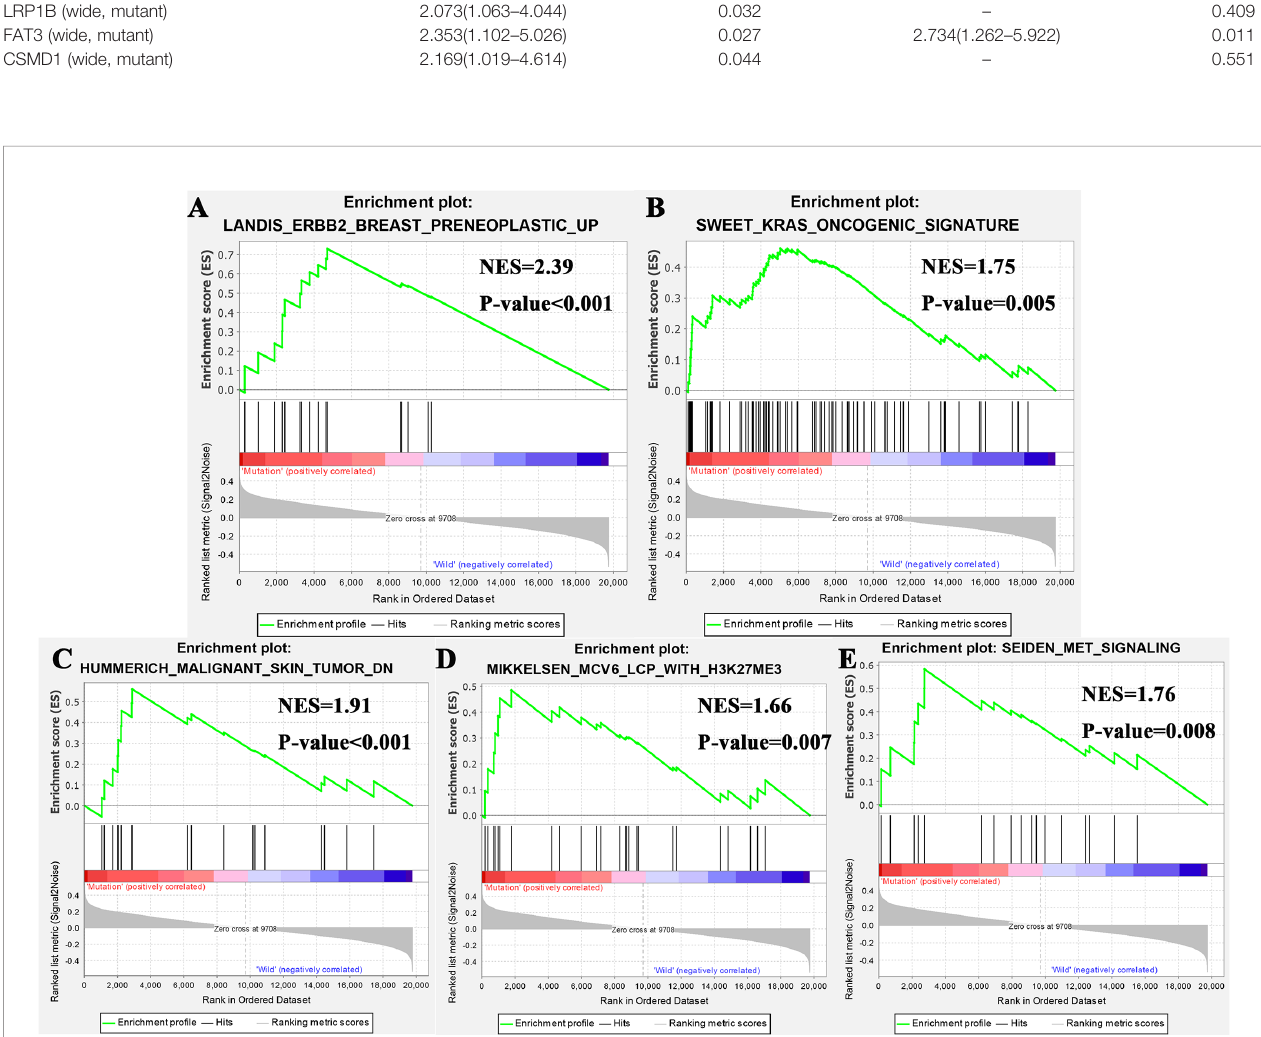
FIGURE 4 | Signi fi cantly enriched pathways associated with FAT3 mutation. GSEA was performed with TCGA to explore the function role of FTA3 mutation. The GSEA analysis showed that samples with FAT3 mutation enriched in (A) ERBB2 Breast Preneoplastic UP, (B) Kras Oncogenic Signature, (C) “ Malignant Skin Tumor DN, (D) MCV6 LCP With H3K27ME3 pathway, and (E) MET Signaling pathway. NES, normalized enrichment